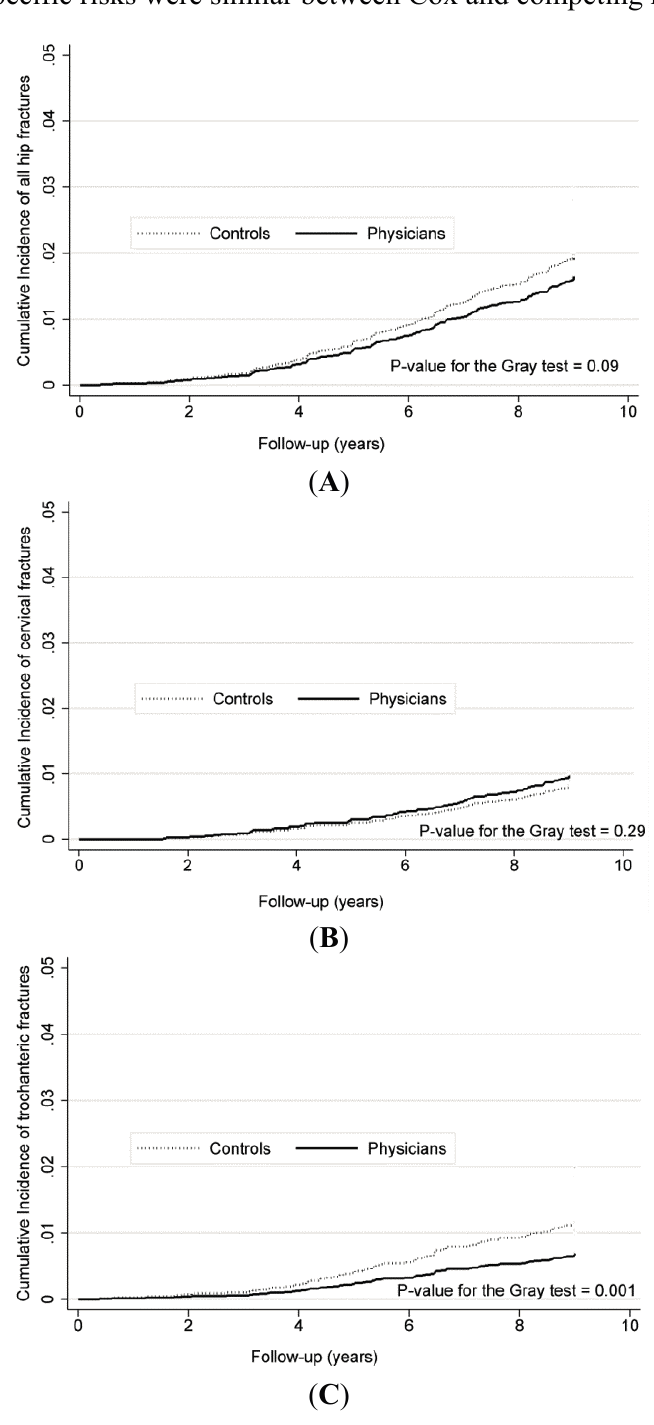
Figure 2. Comparisons of cumulative incidence functions of overall ( A ) and type-specific hip fractures ( B , C ) between the two groups, 2000 –